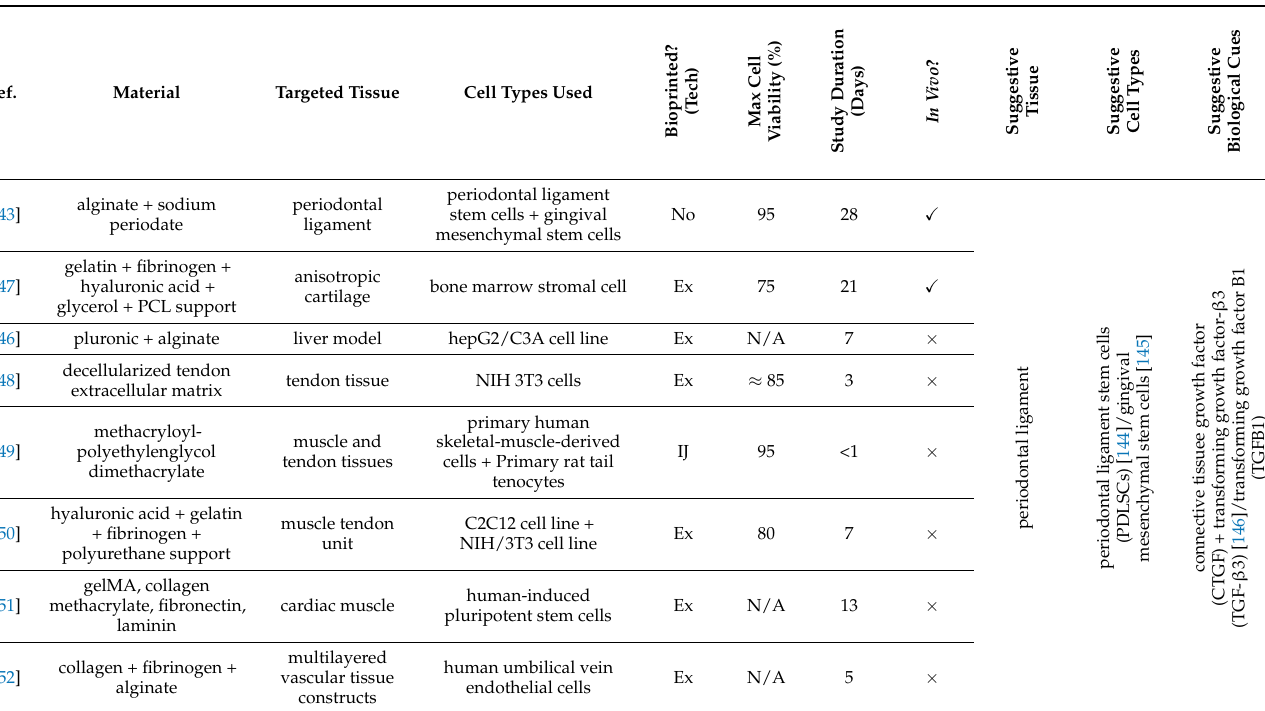
Table 3. An overview of some candidate materials with potential to be used in bioprinting for periodontal ligament and alveolar bone, along with cell types and biological cues useful for the purpose. (IJ: inkjet, EX: extrusion. L: laser